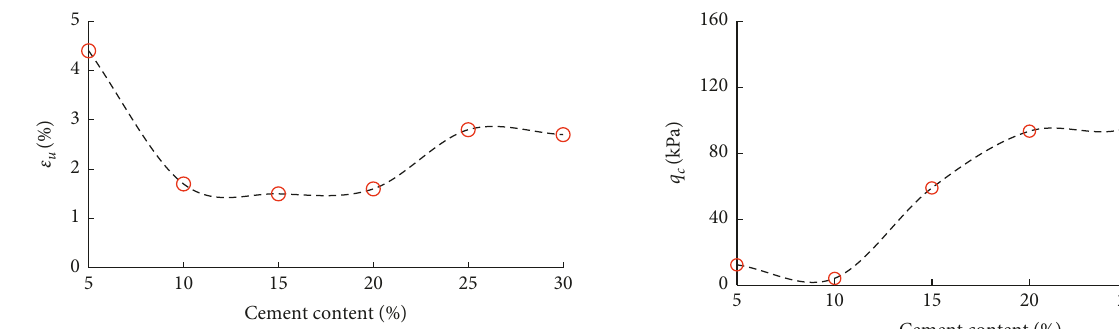
Figure 19: Residual strength q c of slurry with various cement